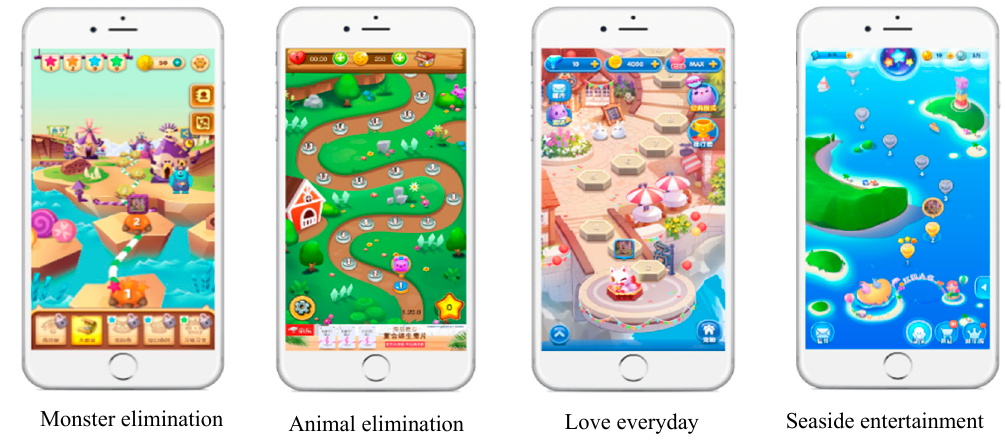
Figure 1. The name of four selected experimental materials.